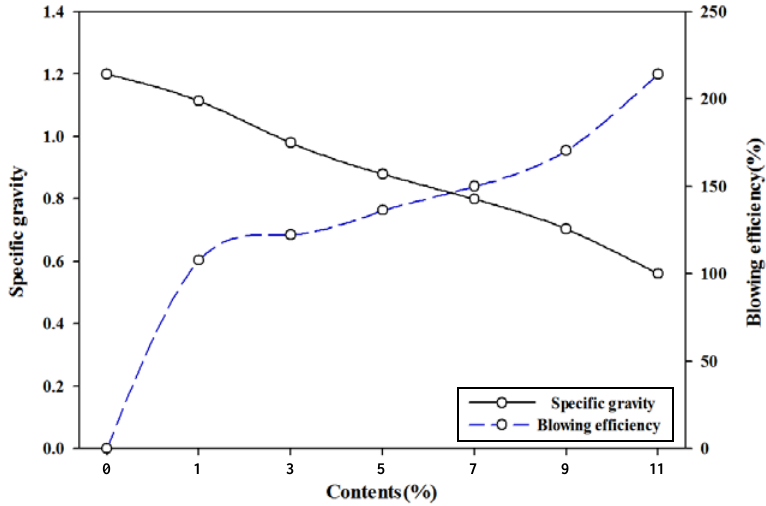
Figure 1. Specific gravity and blowing efficiency of polyester thermoplastic film with various contents of thermally expandable microcapsules.